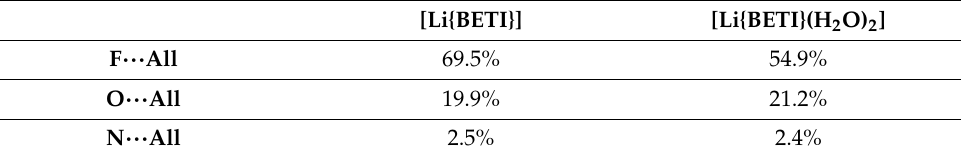
Figure 10. Depiction of hydrogen bonding ring interactions in [Li{BETI}(H 2 O) 2 ]. Different highlights are used to distinguish different hydrogen bonding rings which are formed. Green = 𝑅 (cid:2870) (cid:2870) (cid:4666)8(cid:4667);purple 𝑅 (cid:2871) (cid:2871) (cid:4666)8(cid:4667); yellow (cid:3404) 𝑅 (cid:2870) (cid:2870) (cid:4666)8(cid:4667). a = − x, 1 − y, 1 − z; b = − x, 2 − y, 1 − z. Given the absence of water molecules, the oxygen atoms in 1 show a markedly dif- ferent set of interactions. Predominantly there are no overtly stabilizing non-covalent in- teractions [53,54] arising from the oxygen atoms. All four of the oxygen atoms are binding to a lithium ion, with O1 and O3 acting as the bidentate binding points, while O2 and O4 act as the bridging points to the adjacent lithium ions. The majority of the ~20% of the O